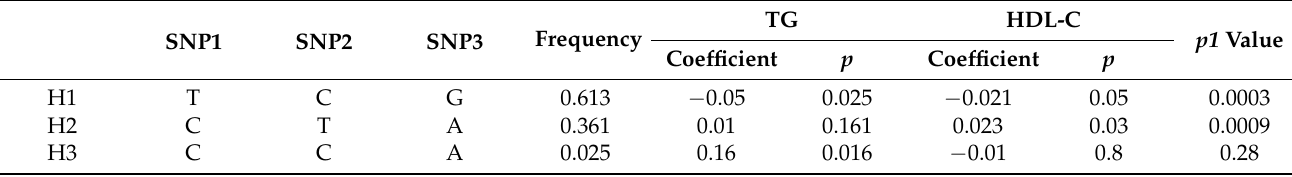
Table 2. Association of LIPC haplotypes with HDL-C level.